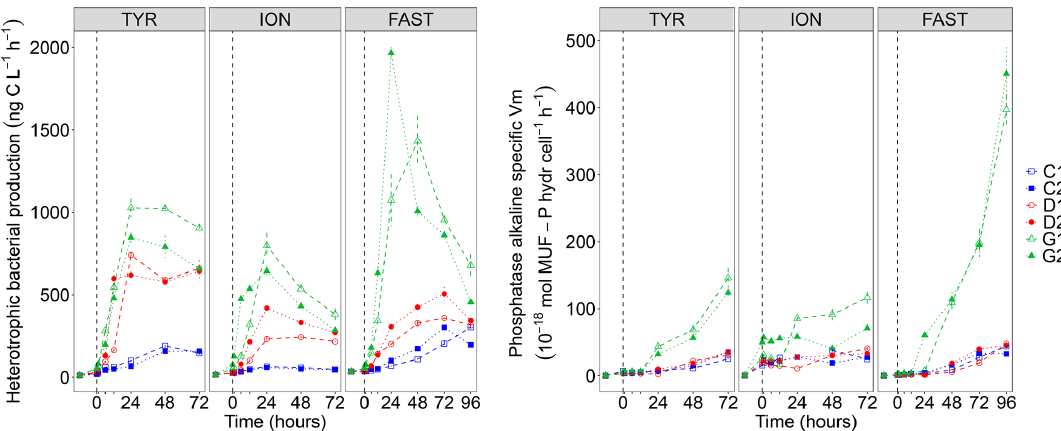
Figure 7. Heterotrophic bacterial production rates (BP) and cell-specific maximum hydrolysis velocity ( V m ) of the alkaline phosphatase (both over 1–2h incubations) on samples taken in the six tanks (C1, C2, D1, D2, G1 and G2) during the three experiments (TYR, ION and FAST).